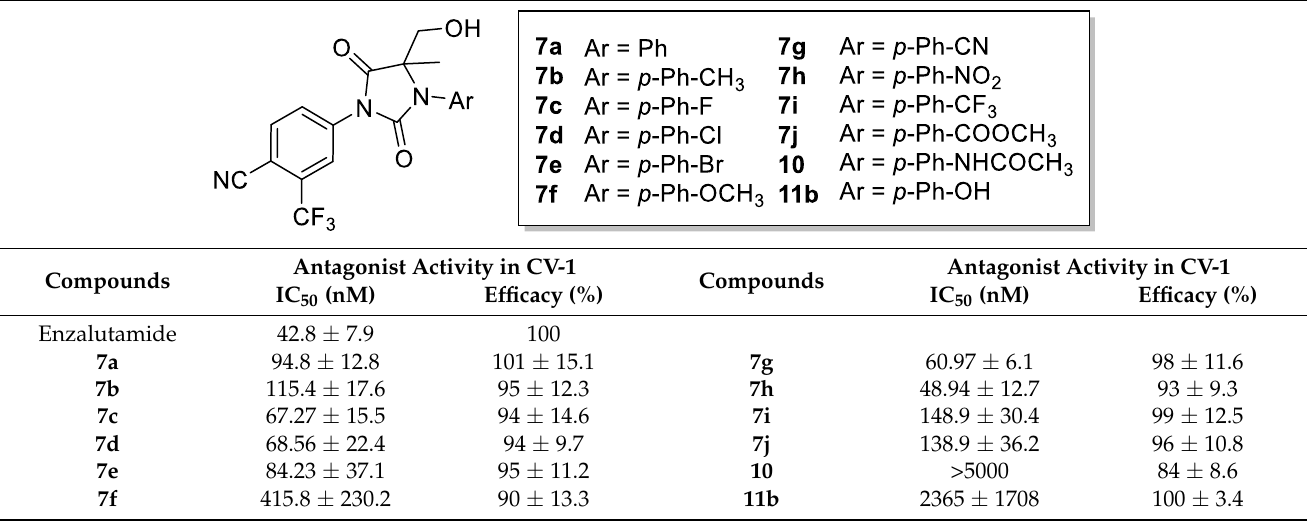
Table 2. Bioactivity of compounds 7a-j , 10 and 11b .